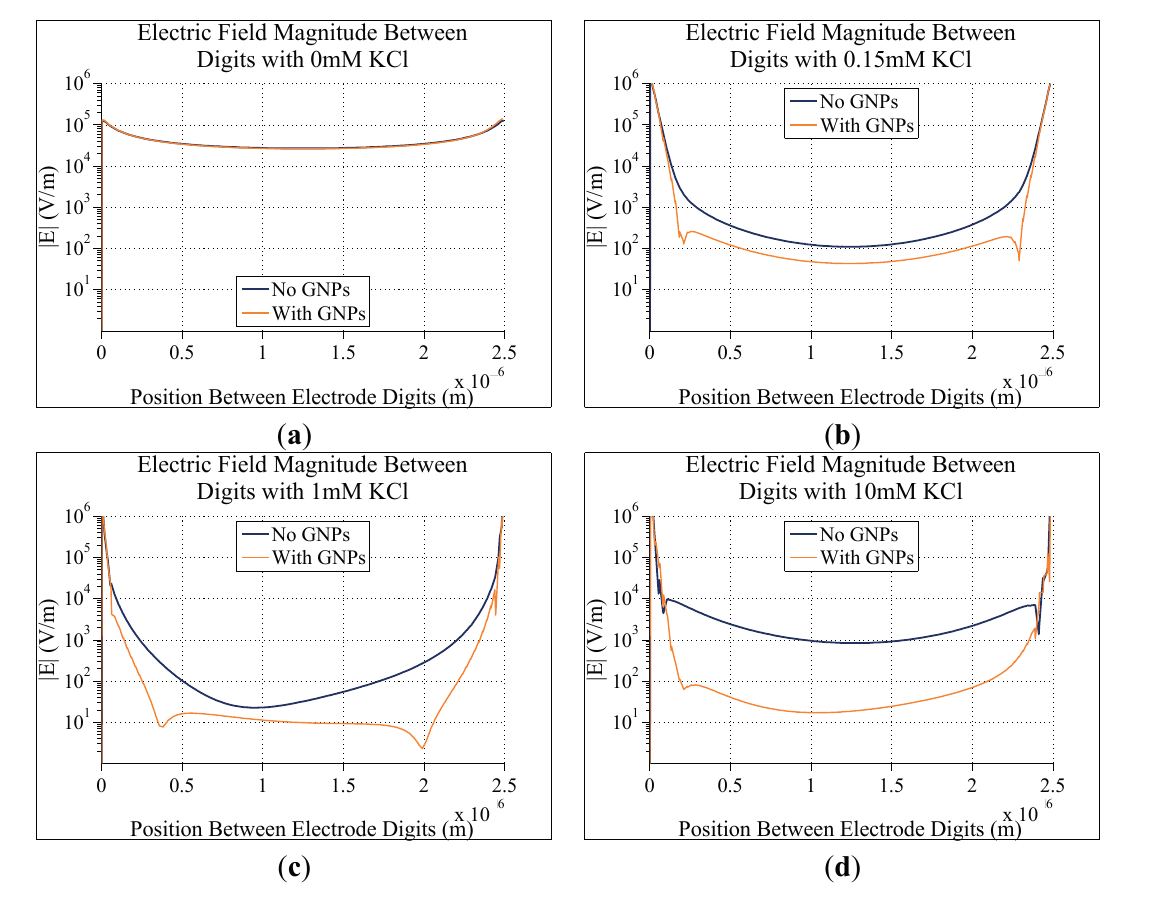
Figure 8. Graphs comparing the simulated electric field magnitude directly between two digits of electrodes with and without bound gold nanoparticles. In all cases, electrodes consisted of 5 µm digits with 2.5 µm gaps between digits, and 0.1 V DC applied to them. The only difference between each graph is the concentration of KCl in the solution in the electrodes: ( a ) 0 M; ( b ) 0.15 mM; ( c ) 1 mM; and ( d ) 10